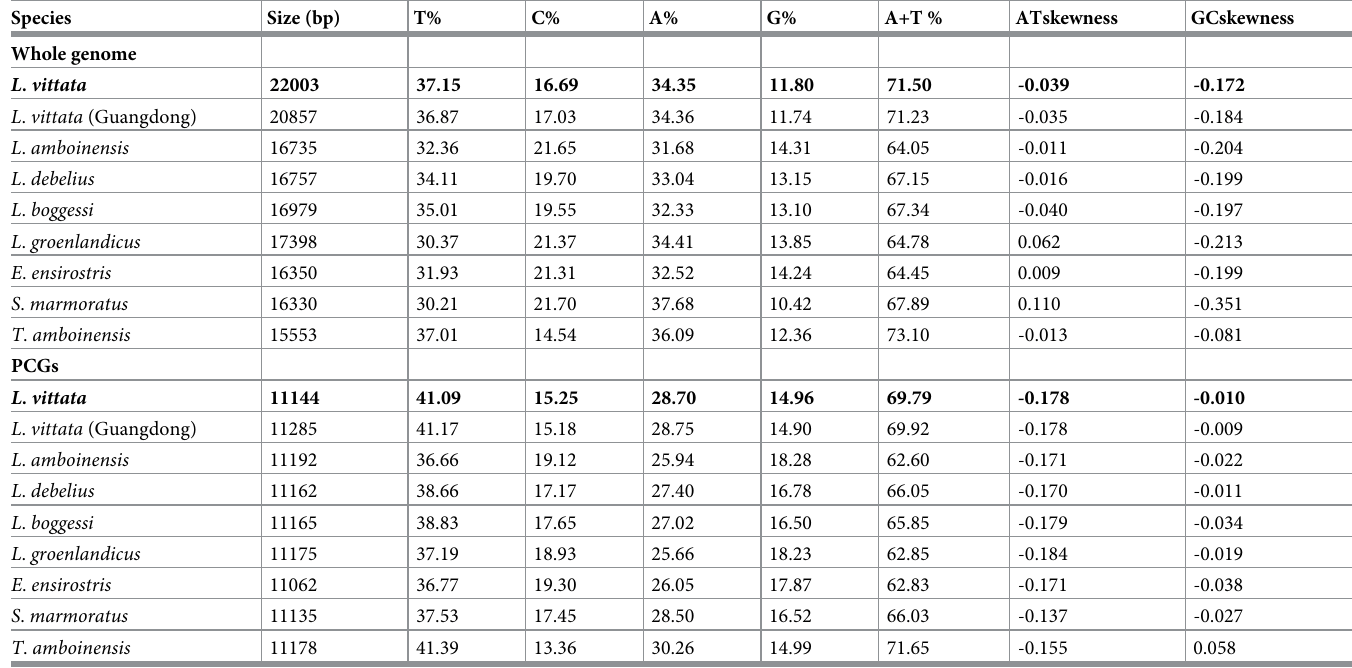
Table 1. Composition and skewness of mitogenome in 9 Hippolytidae species. Species